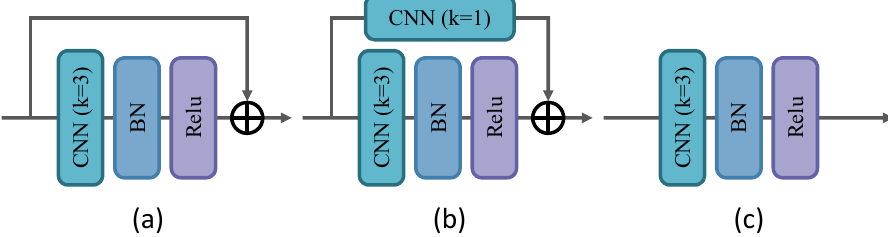
Figure 2. The flow chart of the basic block of ResNet and common CNN options. ( a ) The structure of ResNet, ( b ) the variant of ResNet applied when the I/O channels are different, and ( c ) the basic CNN options without